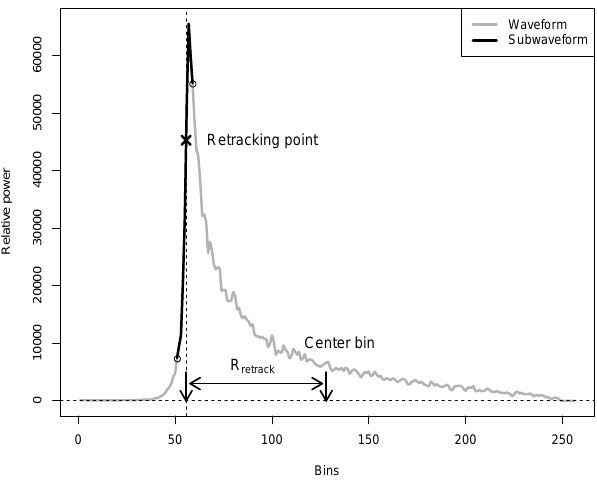
Figure 2. Explanation of the retracking